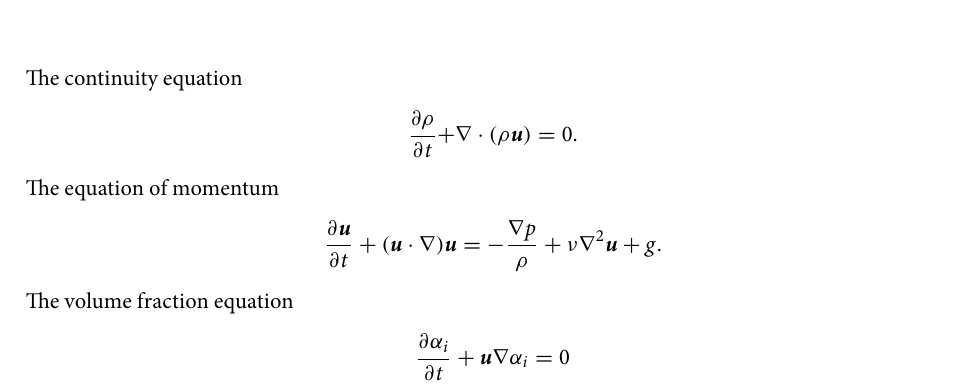
Table 2. Characteristic parameters of horizontal axial flow pump flow